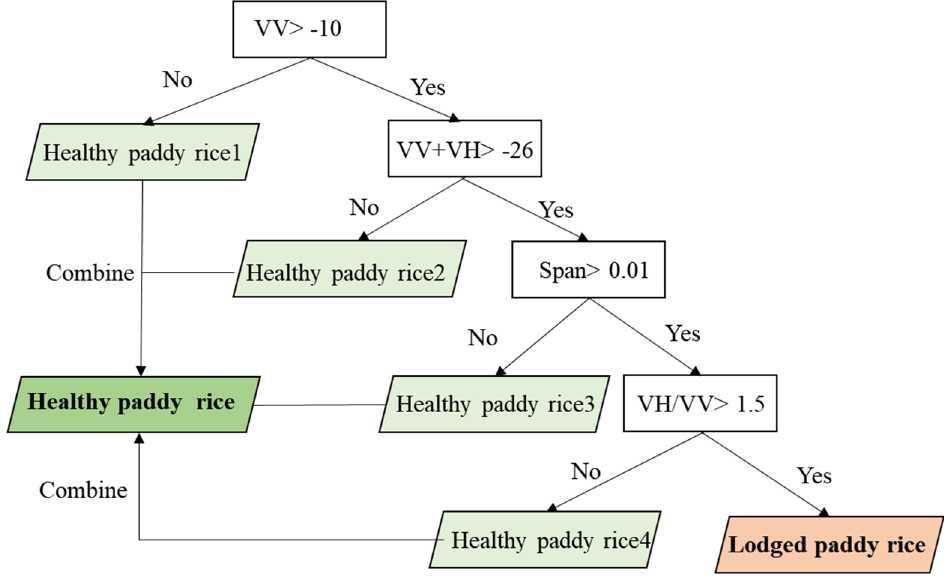
Figure 8. Decision-tree model for classification of healthy and lodged paddy rice.